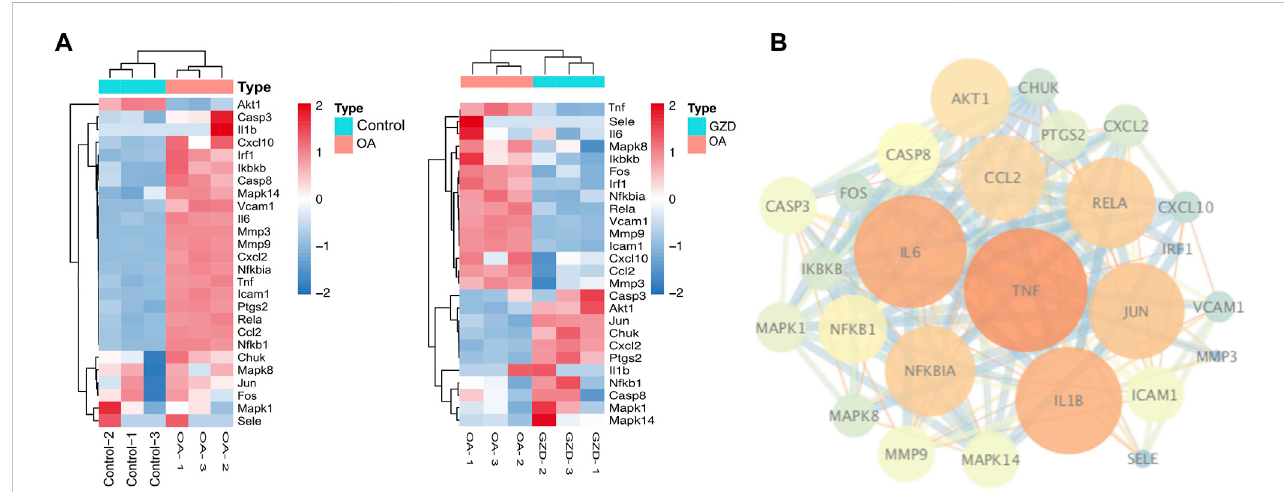
FIGURE 4 Analysis of hub genes in relation to RNA-seq of GZD-treated OA. (A) PPI network constructed genes in the key (TNF) signaling pathway; orange dots represent hub targets of the degree value in the OA and Control (left) groups or the OA and GZD (right) groups. (B) Heatmap shows the scaled expressions of differentiallyexpressedgenesde fi ningtheOAandGZDgroupsintheTNFsignalingpathway,andreddotsshowthatthegenelevelareupregulatedandGreen dots are